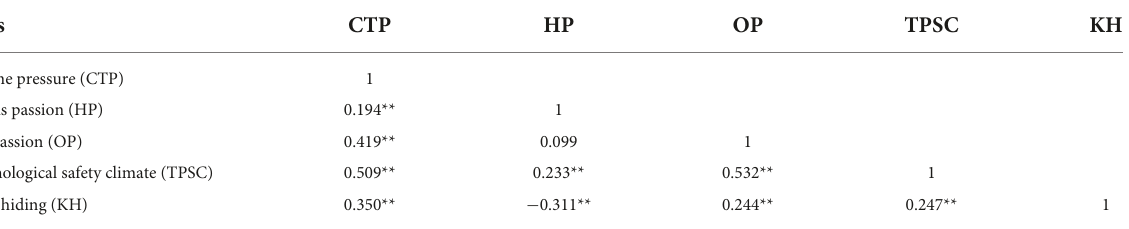
TABLE 3 Coefficients of variables.